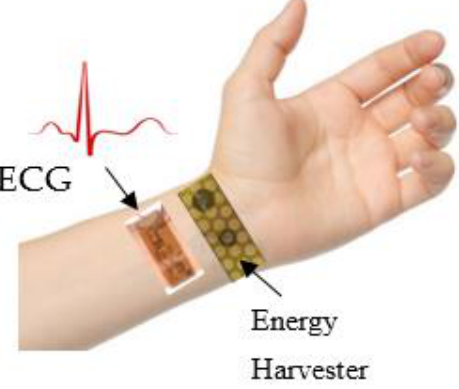
Figure 1. Illustration of a self-powered wearable electrocardiography (ECG) system. The ZnO energy harvester is intended to be placed on the skin of the arm.